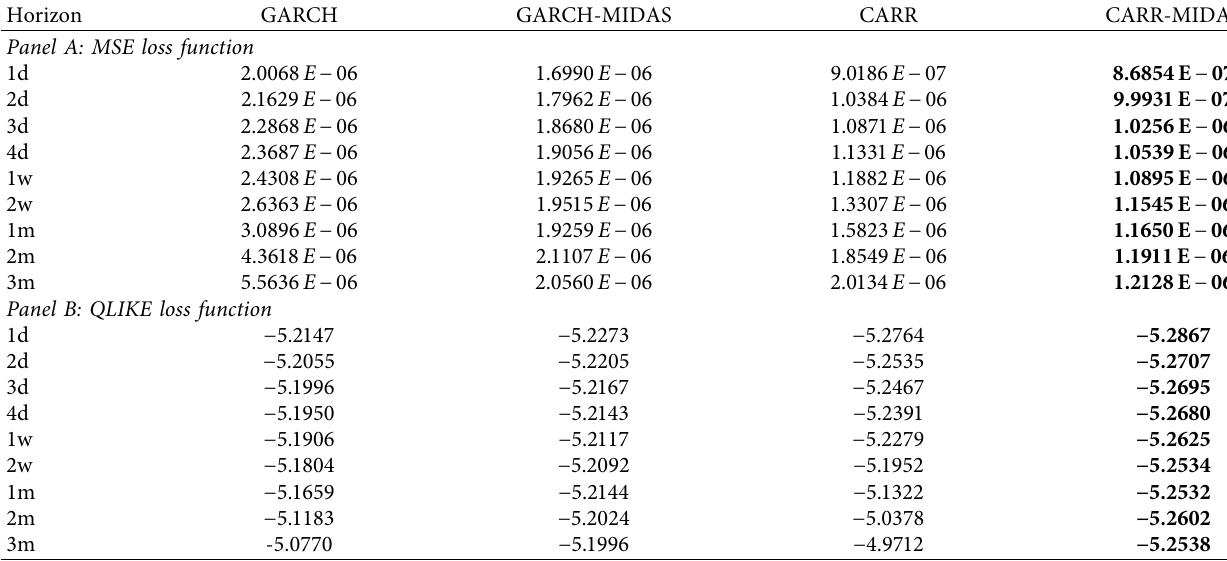
Table 5: Out-of-sample forecast evaluation results for forecast window of 500.